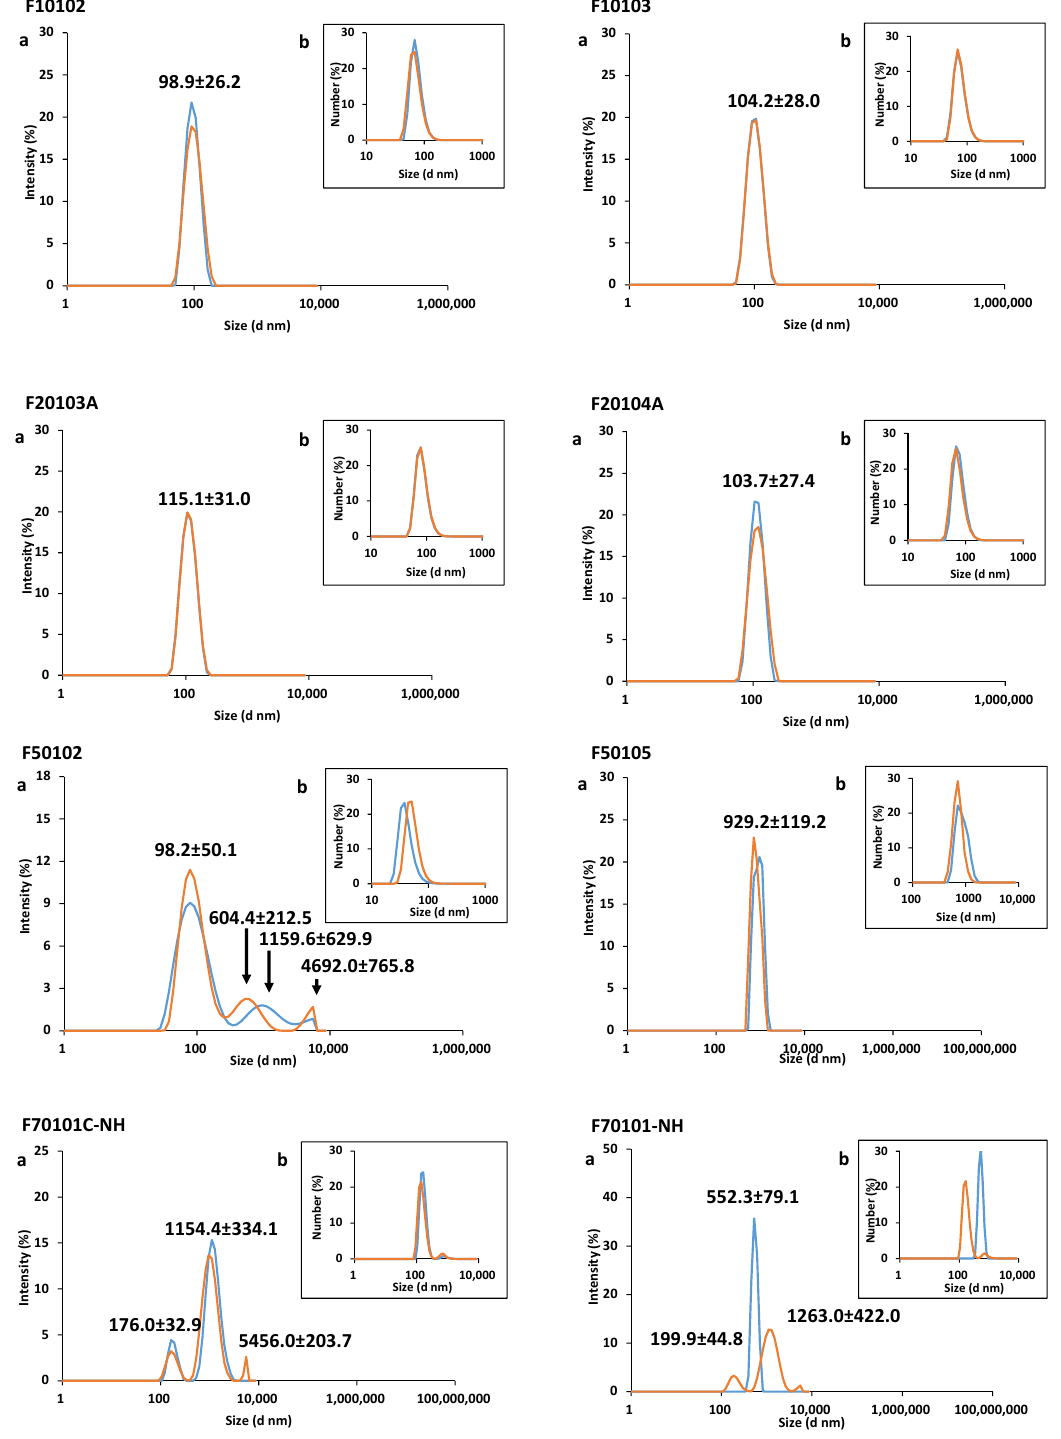
Figure 2. Batch-mode DLS data reported (a) as intensity-based size distribution, and (b) as number-based size distribution. Samples at 25 and 50 µ g/mL (red and blue lines, respectively) were prepared in PBS. Average of three measurements are shown. The PDI of all liposomes is reported in Table